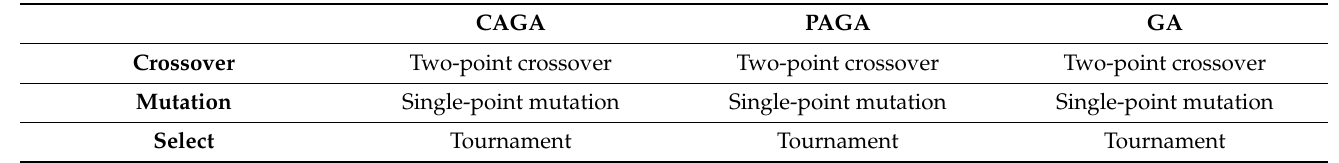
Table 2. Simulation parameter configuration for